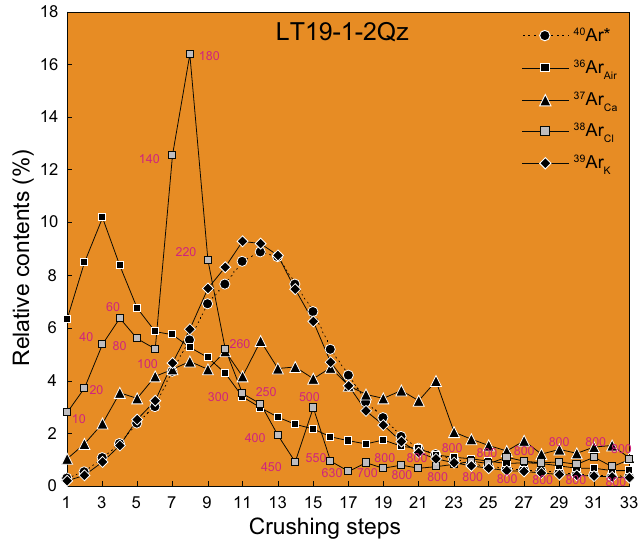
Figure 6. Release patterns of argon isotopes during the in vacuo progressive crushing experiment. The number of pestle drops per stage is marked on the 38 Ar Cl